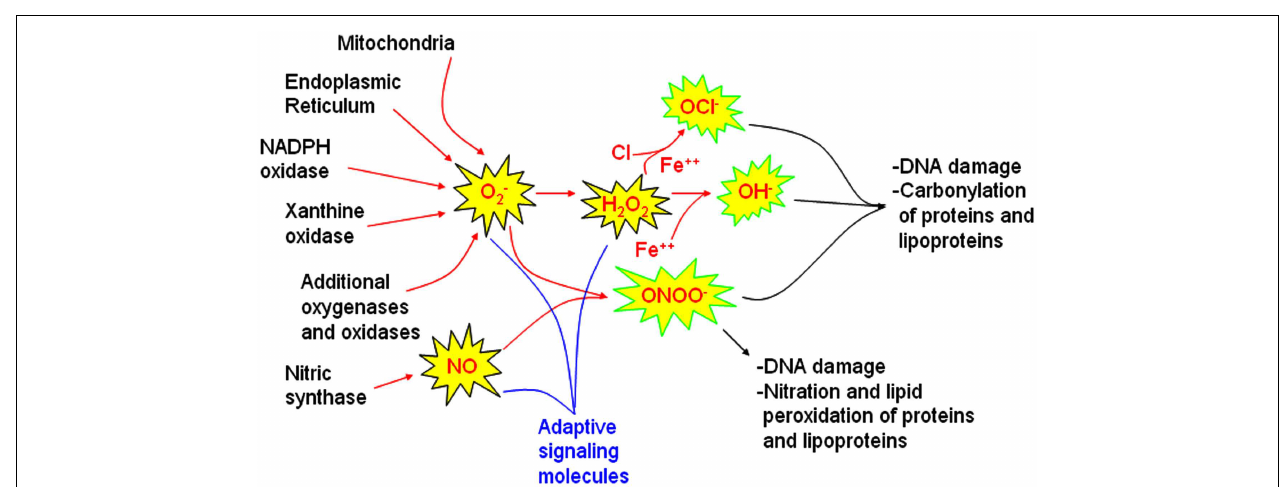
patterns.These ROS and RNS sources may be activated for healthy signaling to increase superoxide (O 2 − • ) nitric oxide (NO) and hydrogen peroxide (H 2 O 2 ). When these molecules are not rapidly cleared, hypochlorite (OCl − ), hydroxyl (OH • ) and peroxynitrite (ONOO − ) radicals can develop.These highly reactive molecules are more likely to cause end-organ damage. Comprehensive examination of end-organ oxidative stress damage requires characterization of oxidative DNA damage, carbonyl, nitration, and lipid peroxidation